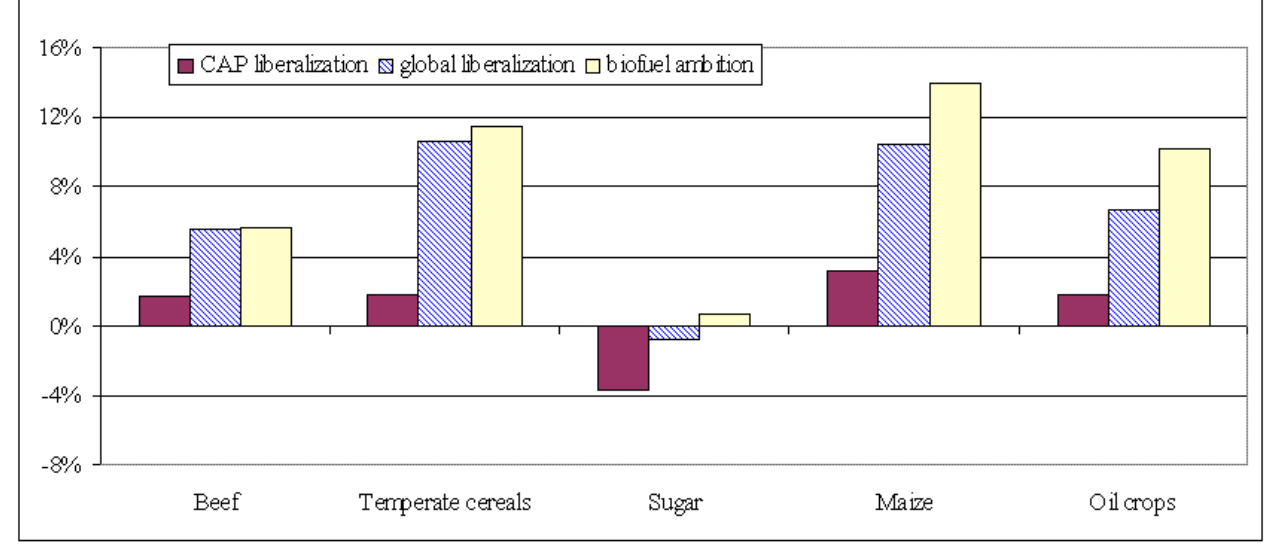
Fig. 4 . Change in real world prices of beef, temperate cereals, sugar, maize, and oil crops in the Common Agricultural Policies (CAP) Liberalization option, the Global Liberalization option, and the Biofuel Ambition option relative to the Baseline in